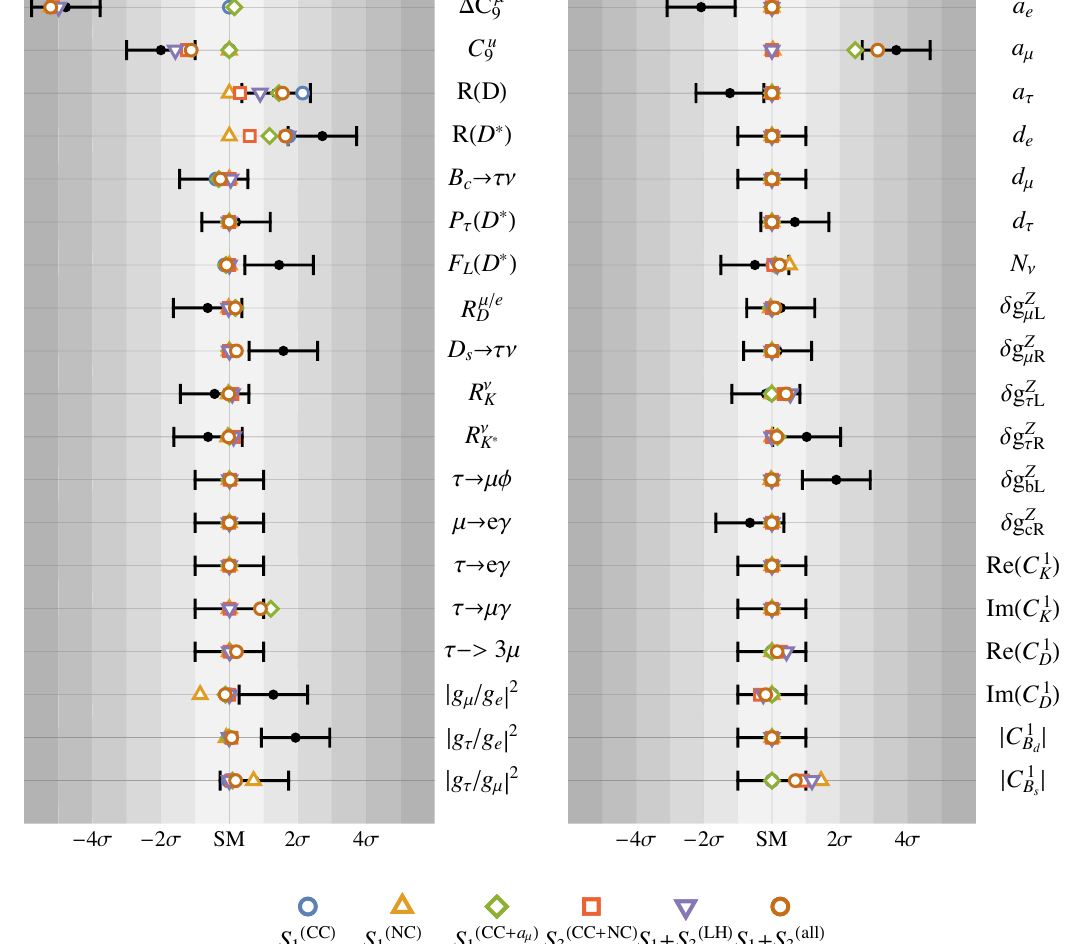
Figure 9 . For the best-fit points in each model studied in this work, we show the relative devi- ations from the Standard Model prediction in all observables, in terms of number of sigmas given by the experimental precision in that observable. The black intervals represent the experimental